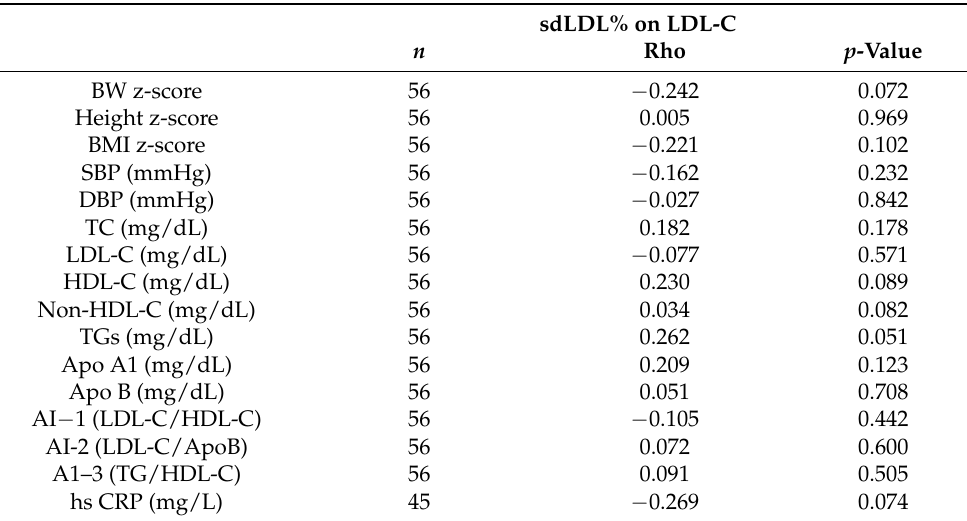
Table 5. Correlation of sdLDL-C % on total LDL-C with clinical and biochemical parameters (Spear- man’s